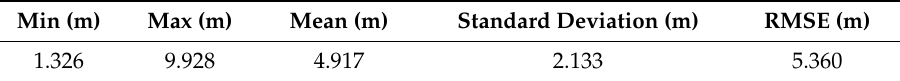
ED50 plane coordinates of CPs with the exact values, the residuals reported in Table 2 are achieved. Table 2. Statistical values of CP residuals for the nautical chart. Table 2. Statistical values of CP residuals for the nautical